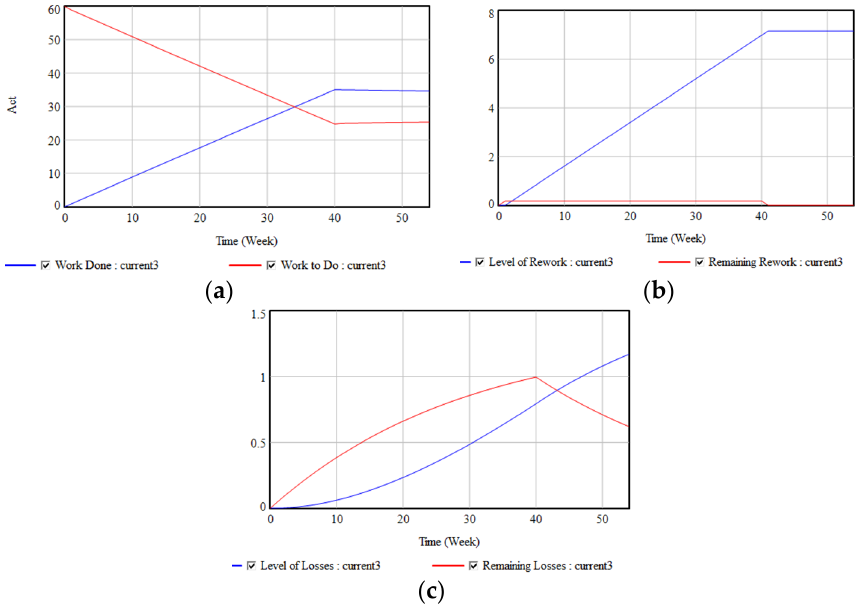
Figure 5. ( a ) Simulation results for 𝑉 (cid:2871)(cid:2869) : Work Done and Work to Do . ( b ) Simulation results for 𝑉 (cid:2871)(cid:2869) : Level of Rework and Remaining Rework . ( c ) Simulation results for 𝑉 (cid:2871)(cid:2869) : Level of Losses and Remaining Losses .